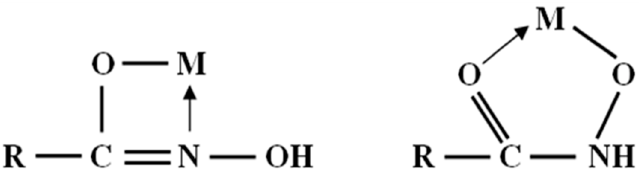
Figure 1. Chelate products of hydroximic acid with metal cations.